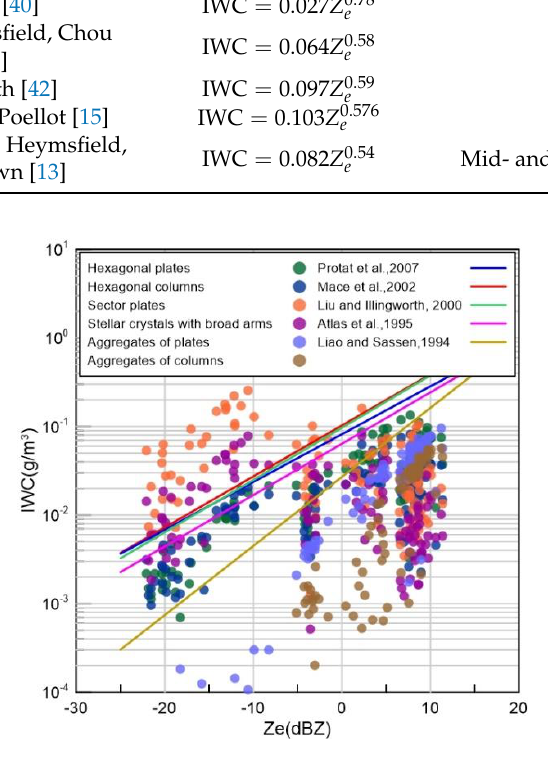
Figure 11. Relationship between 𝑍 𝑒 and ice water content (IWC).